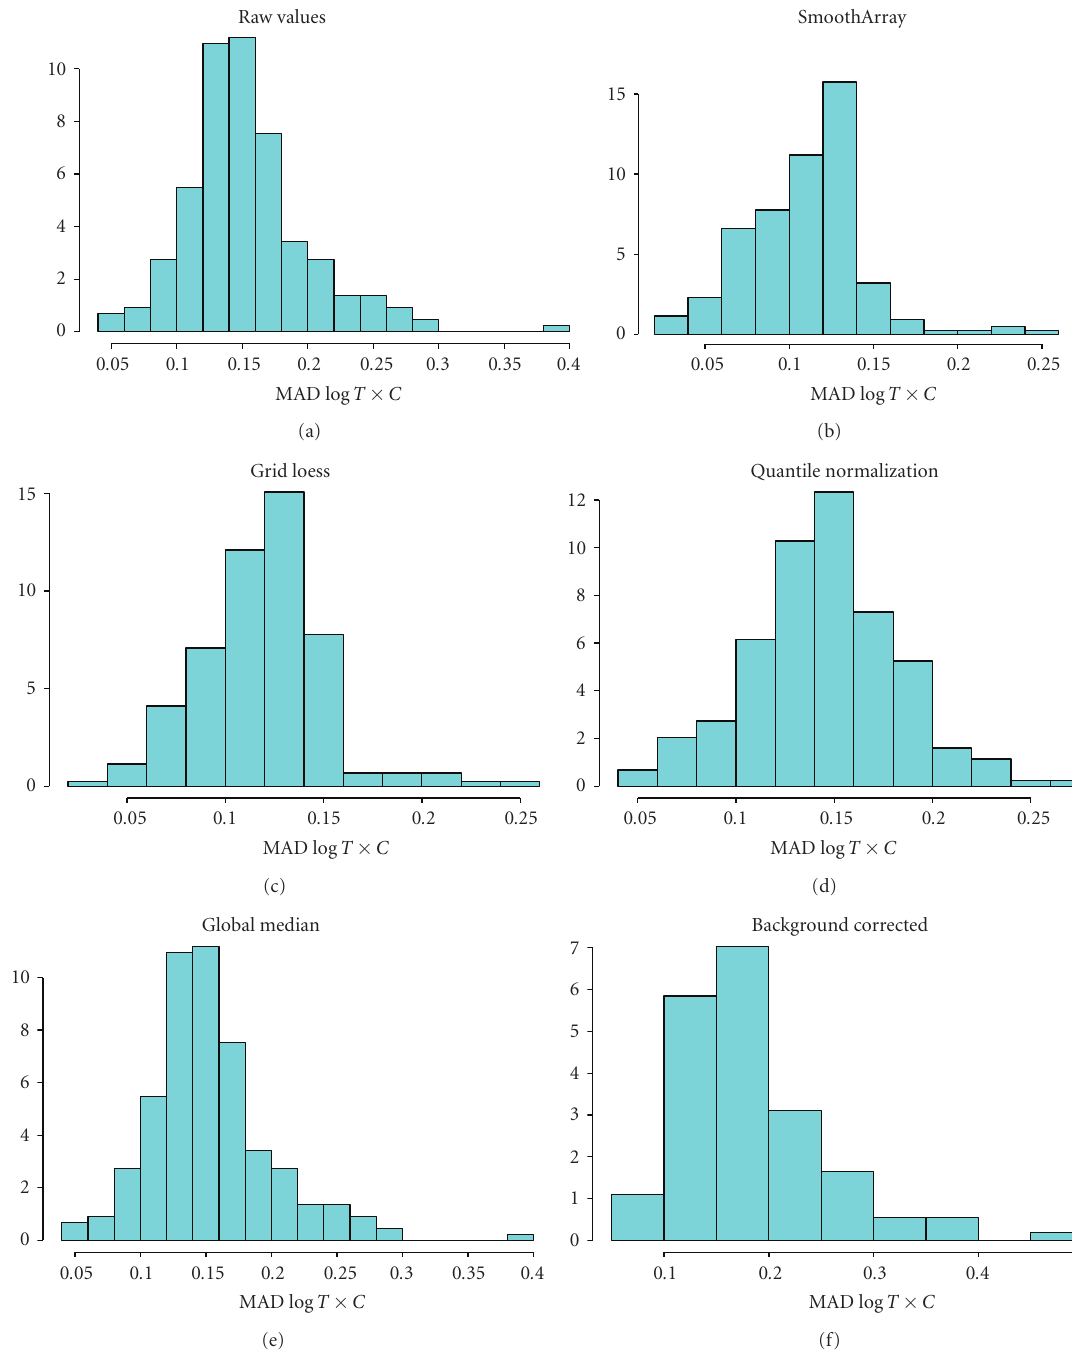
Figure 11: Distribution of the MAD: for each normalization method, the distribution of the MAD values for the log ratio of each probe on the X chromosome. The median for each of the distributions is summarized in Table 2. According to Table 2, the smallest median MAD is obtained using the “SmoothArray” algorithm.